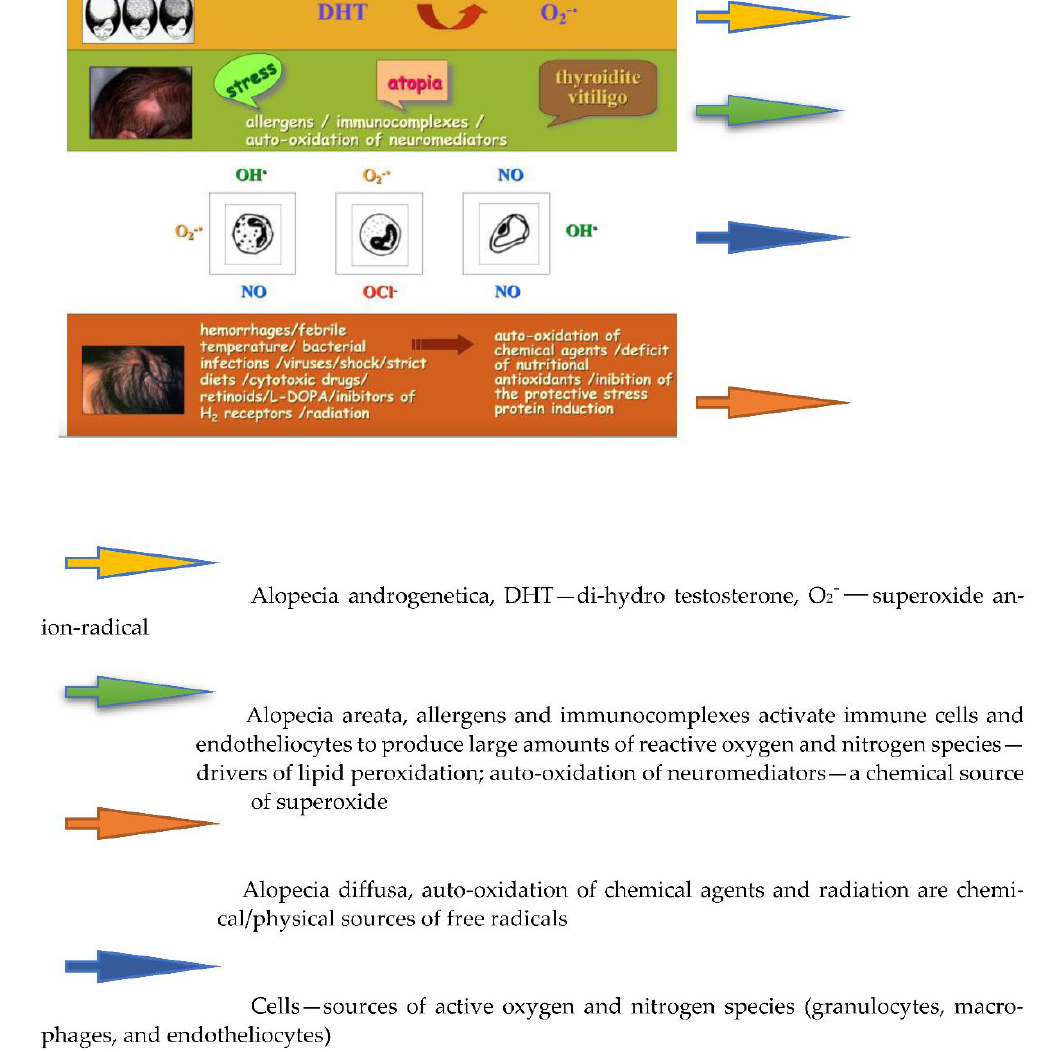
Figure 11 . Sources of oxidative stress in different types of alopecia. Figure 11. Sources of oxidative stress in different types of